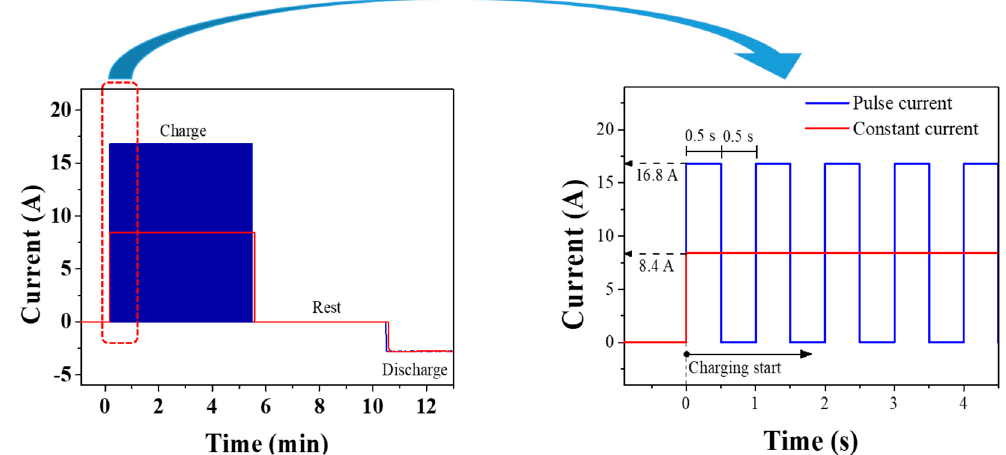
Figure 2. Charging current-time profile of constant current and pulse current procedures.